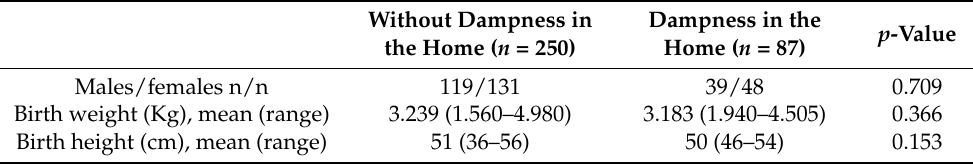
Table 2. Demographic characteristics of children included in this